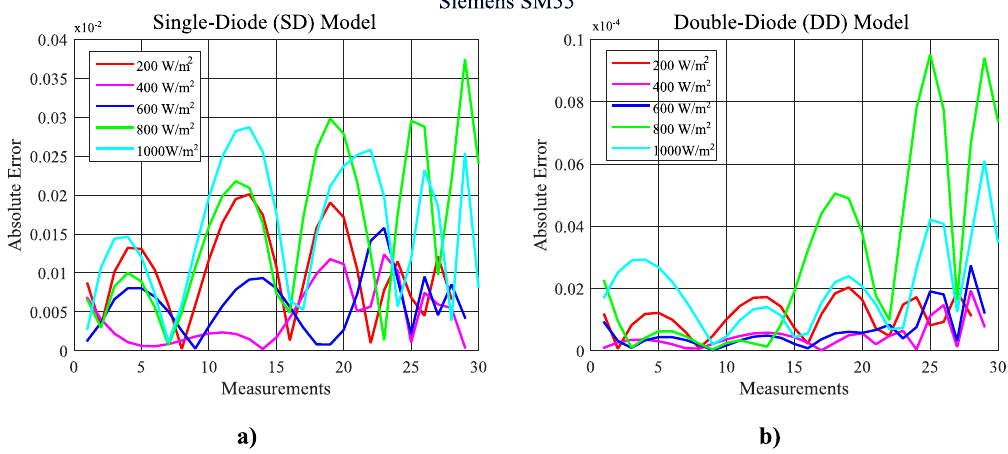
Figure 9. Absolute error curves between the measured and experimental I-V data at different irradiance levels (200, 400, 600, 800 and 1000 W/m 2 ) and fixed cell temperature ( T c = 33 ◦ C ) for an individual cell from a Siemens SM55 Solar Panel. ( a ) SD model and ( b ) DD model.